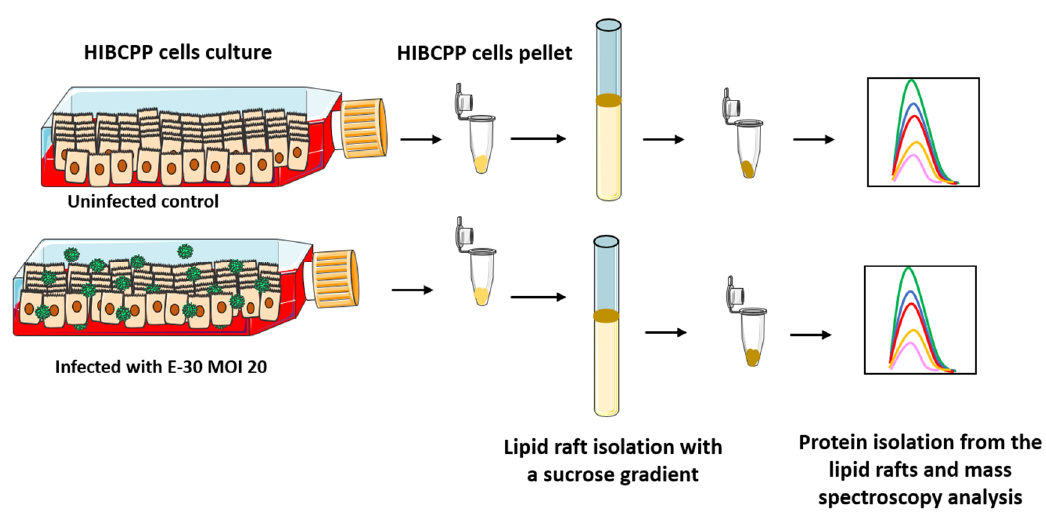
Figure 1. Schematic representation of the lipid raft isolation of HIBCPP (Human Immortalized Choroid Plexus Papilloma) cells. HIBCPP cells were infected with E-30 (Echovirus-30) for 24 h at a MOI (Multiplicity of infection) of 20. Subsequently, the cells were pelleted, and the lipid rafts were isolated using a sucrose gradient [29]. Finally, the protein content of the lipid raft fraction was extracted and analyzed by mass spectrometry. The HIBCPP cells are infected with E-30 on their apical side.